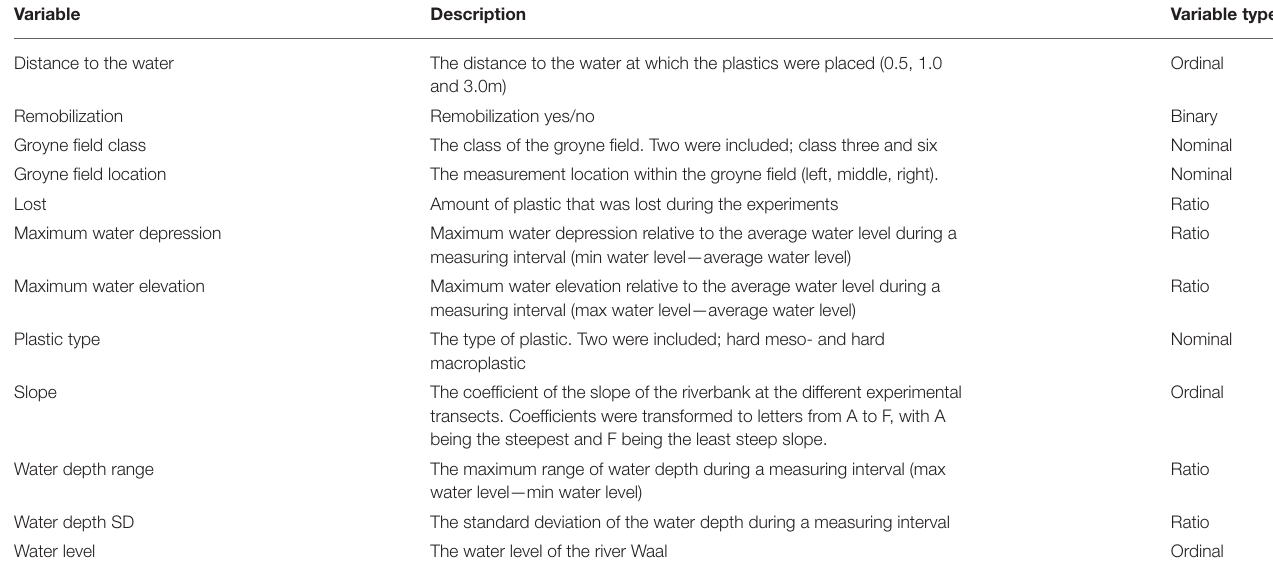
TABLE 1 | Overview of measured variables.